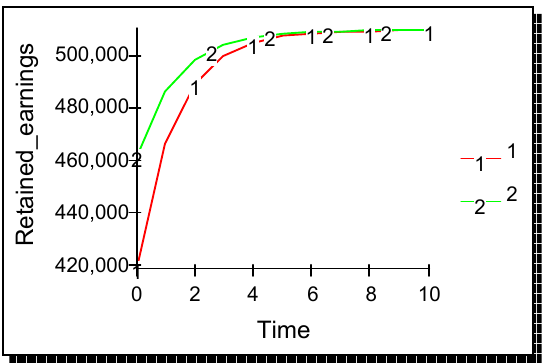
Figure 4. Unilateral demand tilting advertising σ 11 = σ 12 = 1.5 × 10 − 10 ; σ 22 = σ 21 = 0.